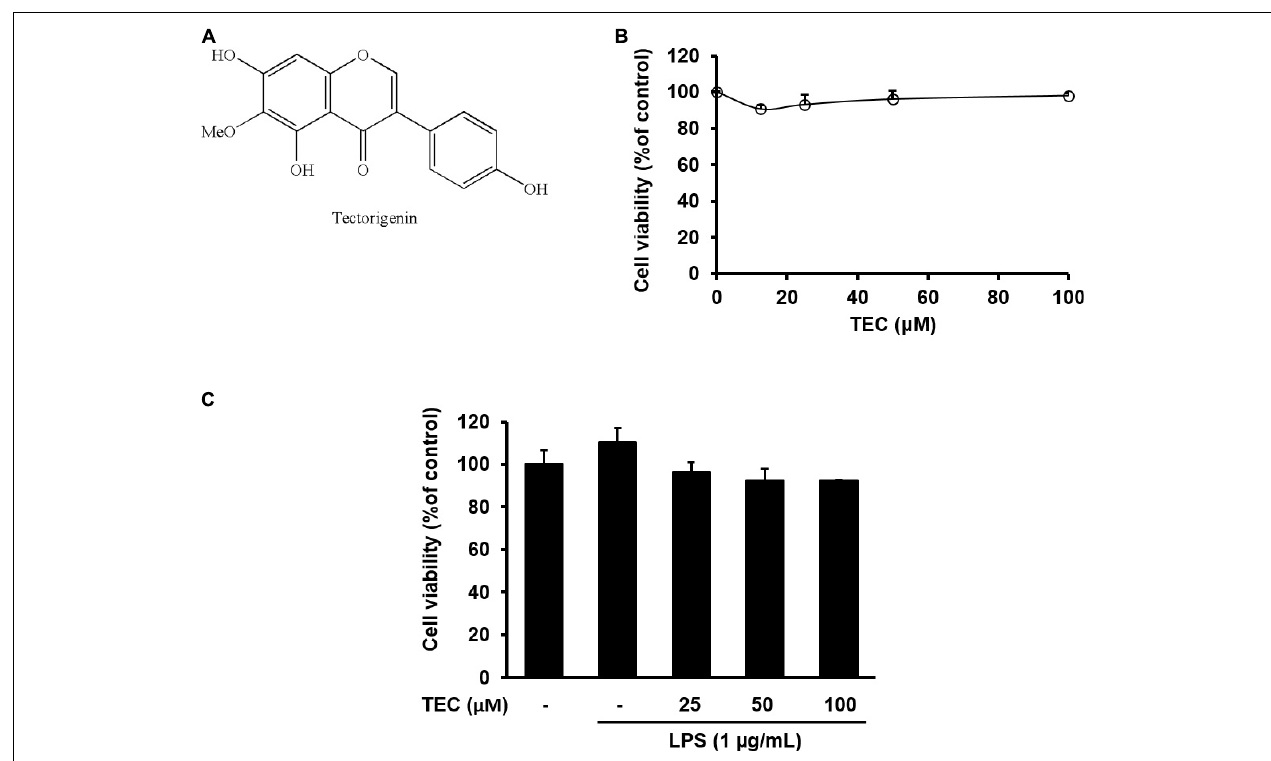
FIGURE 1 | Cytotoxicity of TEC in BV-2 microglia. (A) Chemical structure of TEC. (B) Cells were seeded on 96-well plates and treated with TEC (0, 12.5, 25, 50, 100 µ M) for 24 h. (C) Cell were pretreated TEC (25, 50, 100 µ M) for 2 h followed by treatment with LPS (1 µ g/mL) for 22 h. Cell viability was assessed using the CCK-8 assay. The results are expressed as the mean ± SEM of three independent